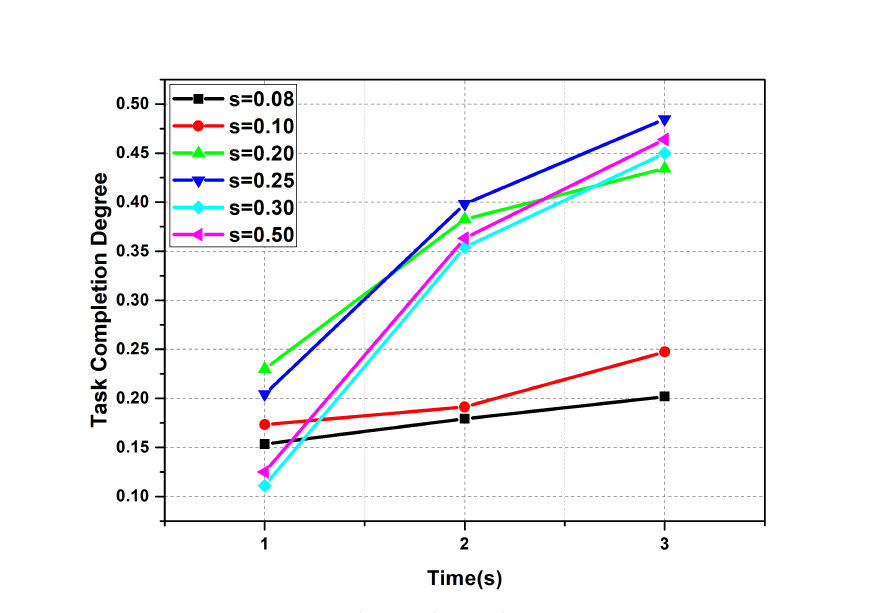
Figure 9. Task completion degree over